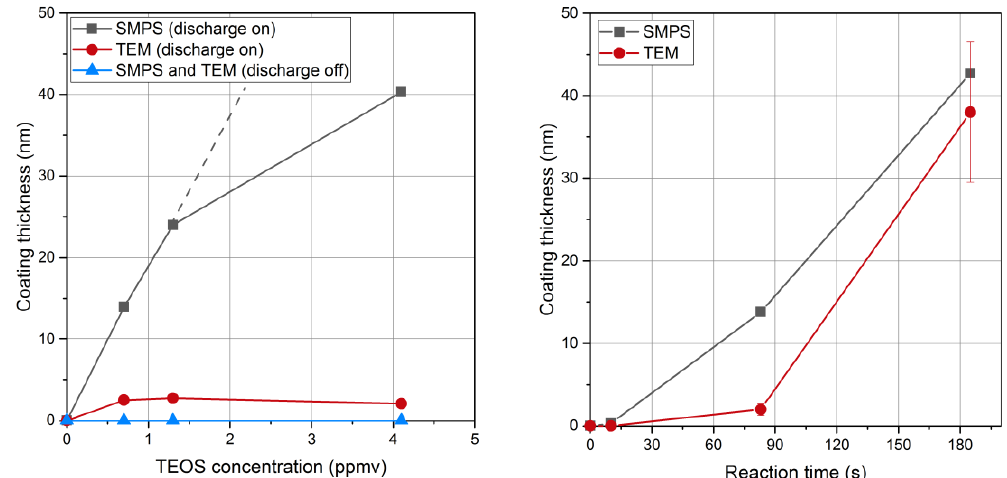
Figure 8. Coating thickness measured with scanning mobility particles sizer (SMPS) and TEM as a function of TEOS concentration for t Reaction = 83 s ( left ) and as a function of the reaction time for 0.7 ppmv TEOS concentration ( right ).